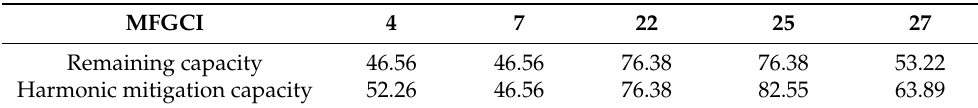
Table 11. Capacity of each MFGCI involved in harmonic mitigation (kW).